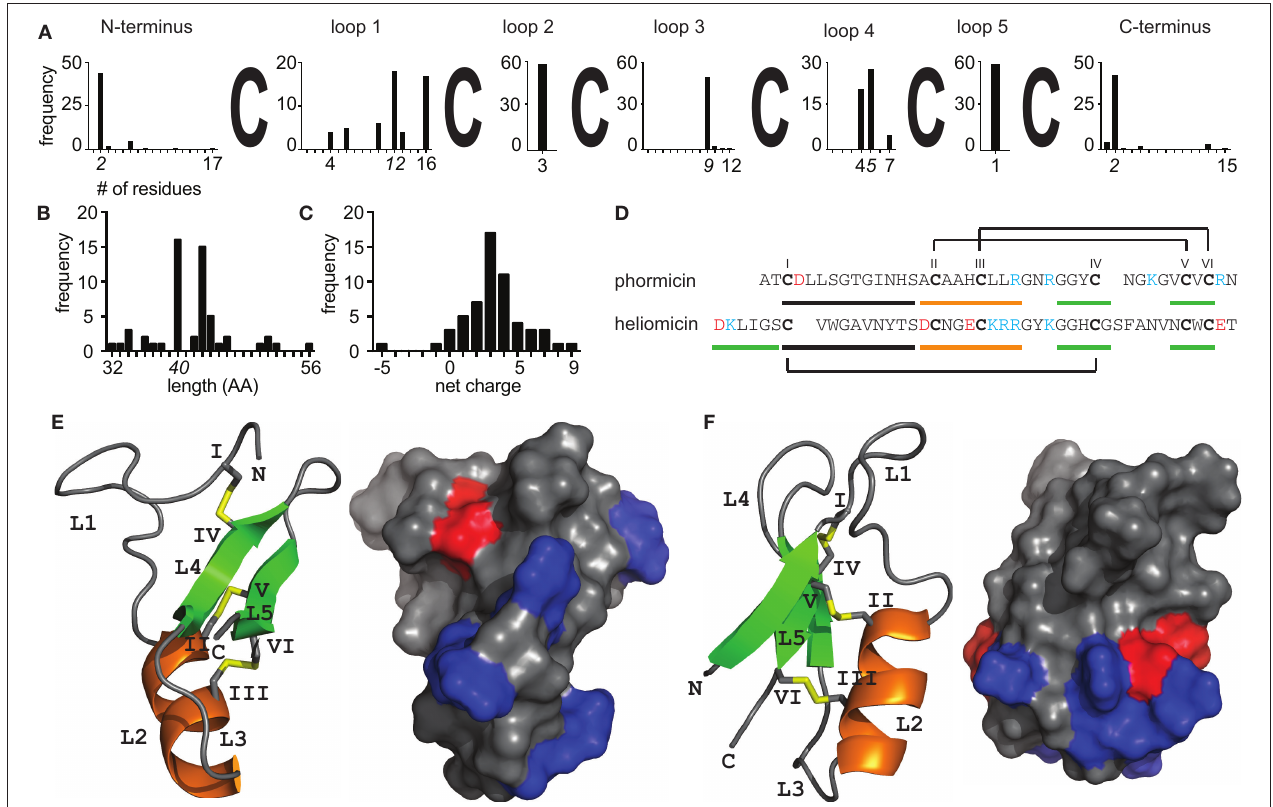
FIGURE 1 | Structural diversity of insect defensins. Sequence analysis of 57 peptides ( Table 1 ) illustrating the diversity of insect defensins. (A) All sequences share a conserved pattern of six cysteine residues. Intercysteine loop 2 ( n = 3) and loop 5 ( n = 1) are fully conserved across all peptides and loop 1 shows the overall highest sequence variability ( n = 4–16). The minimal, maximal, and most abundant (italic font) length of individual sequence stretches are indicated. (B) The length distribution shows that insect defensins are between 32 and 52 residues long, with the majority (54%) being 40 or 43 residues. (C) Insect defensins are typically cationic with reported charges varying between − 5 and + 8 and the majority (49%) of peptides holding a + 3 or + 4 net charge. (D) Sequences of the antibacterial phormicin and the antifungal heliomicin showing the disulfide connectivity of insect defensins. Stretches that form part of the α -helix (orange) and β -sheets (green) are indicated. Solution NMR structures of (E) phormicin (PDB: 1ICA) and (F) heliomicin (PDB: 1I2U) showing the cysteine-stabilized αβ motif. Secondary structural elements, i.e., α -helix (orange), β -sheets (green) and disulfide bonds (yellow) are highlighted, cysteines (roman numerals) and loops (L) are indicated. Surface representations show negatively (red) and positively (blue) charged residues, demonstrating the overall cationic character of the surface of the peptides.